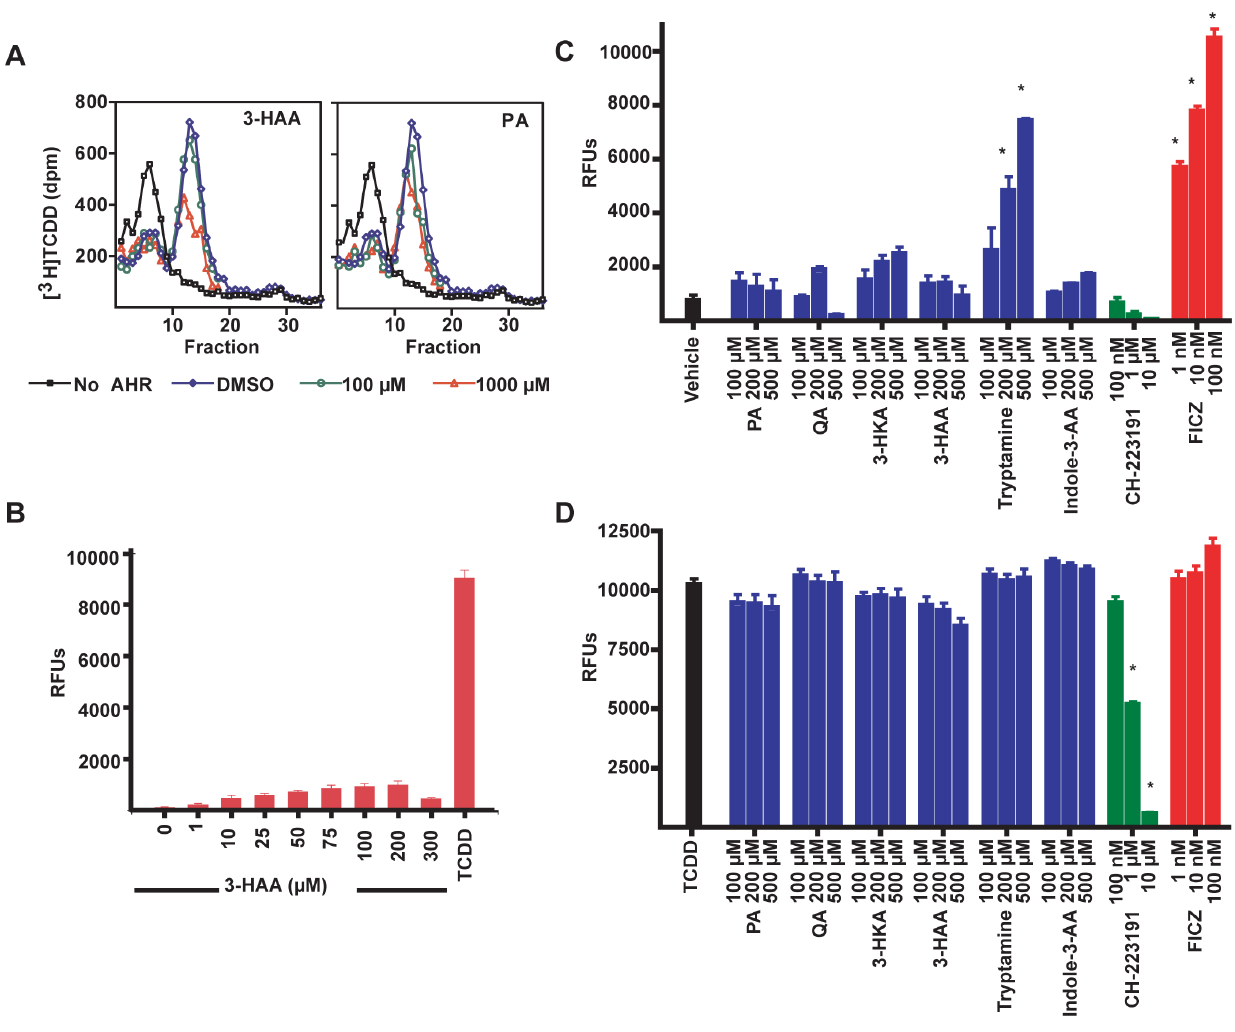
Figure 3. 3-HAA fails to bind or activate the AHR. (A) Displacement of [ 3 H]TCDD from the human AHR in the presence of 3-HAA or PA. Data for 100 m M concentrations were from 2–4 experiments; data for 1000 m M concentrations were from one or two experiments. (B) Fluorescence of an AHR- responsive reporter construct measured after incubation of a stably transfected murine hepatoma cell line in the presence of increasing concentrations of 3-HAA. TCDD (5*10 2 11 M) is a positive control. Error bars are SD. N=6. (C) Fluorescence of the AHR-reporter construct following incubation of transfected cells with 3-HKA, PA, or QA. Tryptamine and FICZ are positive controls. (D) Inhibition of TCDD (10 2 10 -M)-induced activation of the AHR reporter construct. CH-223191 is a positive control. *, p , 0.05 (ANOVA, Scheffe’s). Error bars are